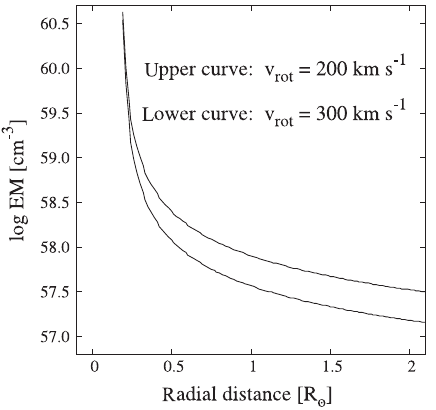
Fig. 5. Two examples of the calculated emission measures EM of the wind from the hot star as a function of the radial distance from the center of the hot star. The emission measures were calculated for the hot star with the mass-loss rate 10 − 6 M ⊙ yr − 1 . Further, we assumed that the radius of the hot star is 0.18 R ⊙ and the boundary between the neutral and ionized zones is given by the polar angle (cid:18) = (cid:25)=